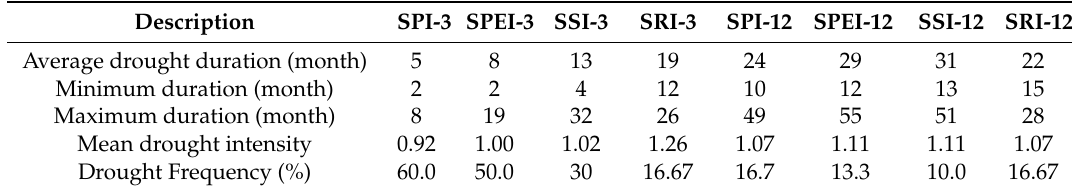
Table 5. Regional drought characteristics in Upper Kafue River Basin (UKRB) from 1984 to 2013. Description